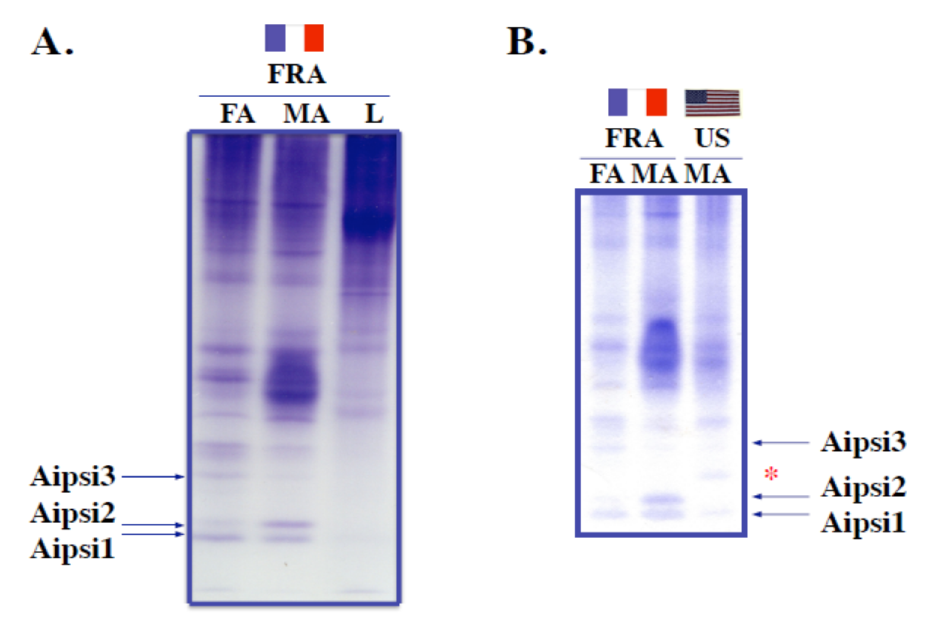
Figure 2. Identification of strain-specific odorant-binding proteins (OBPs) in A. ipsilon . ( A ) Electrophoretic comparison (15% non-SDS PAGE) of antennal soluble protein extracts (FA: female antennae, 40 eq.; MA: male antennae, 40 eq.) to leg soluble protein extracts (L, 40 eq.) from the French A. ipsilon population. ( B ) Electrophoretic comparison (15% non-SDS PAGE) of antennal soluble protein extracts from the French A. ipsilon population to antennal protein extracts from the American A. ipsilon population. FA: female antennae (40 eq.), MA: male antennae (40 eq.), FRA: French population, US: American population. In A and B, three protein bands, Aipsi1, Aipsi2 and Aipsi3, were stained in the zone corresponding to fast-migrating OBP-like proteins and selected for microsequencing. In B, Aipsi1 and Aipsi2 were expressed more highly in the French population of A. ipsilon , while Aipsi3 and another fast-migrating protein Aipsi2′ (*) were expressed more specifically in the US population.